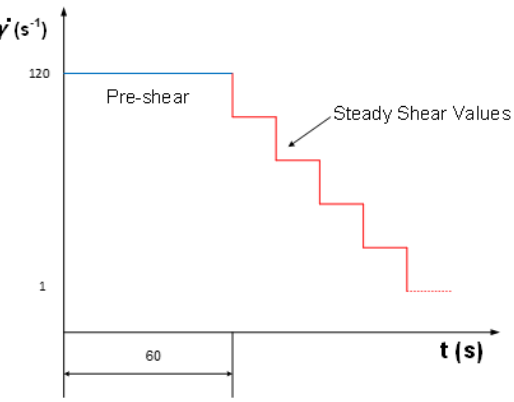
Figure 5. Steady flow curve protocol.